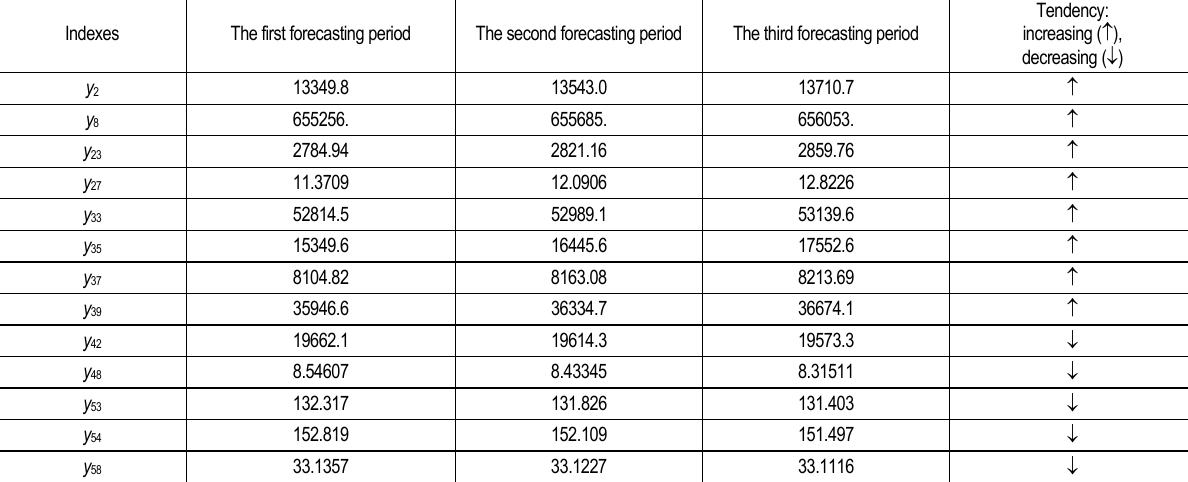
Table 5. Forecasting meanings of indexes of socioeconomic state of Russia The first forecasting period The second forecasting